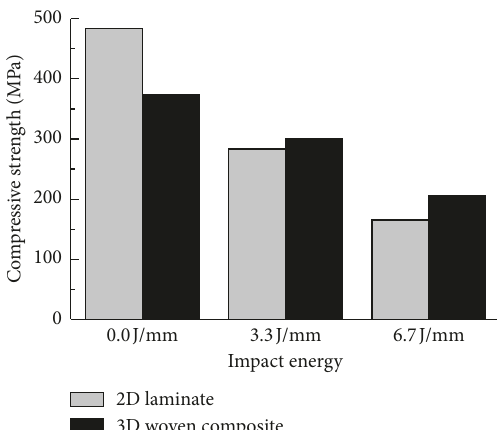
Figure 9: Comparison of compression resistance values before and after impacts of composite materials made with UD laminates and 3D warp interlock fabrics